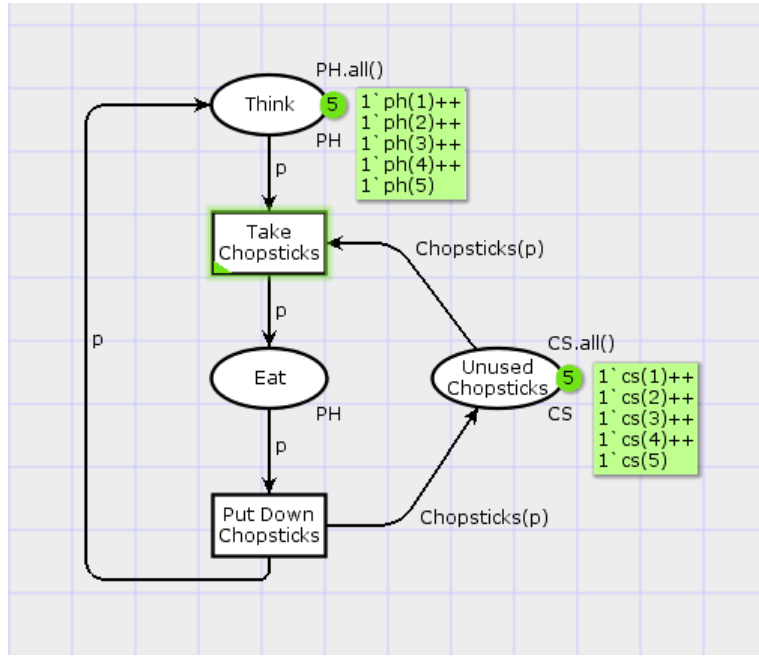
Figure 4. Colored Petri net: dining philosophers